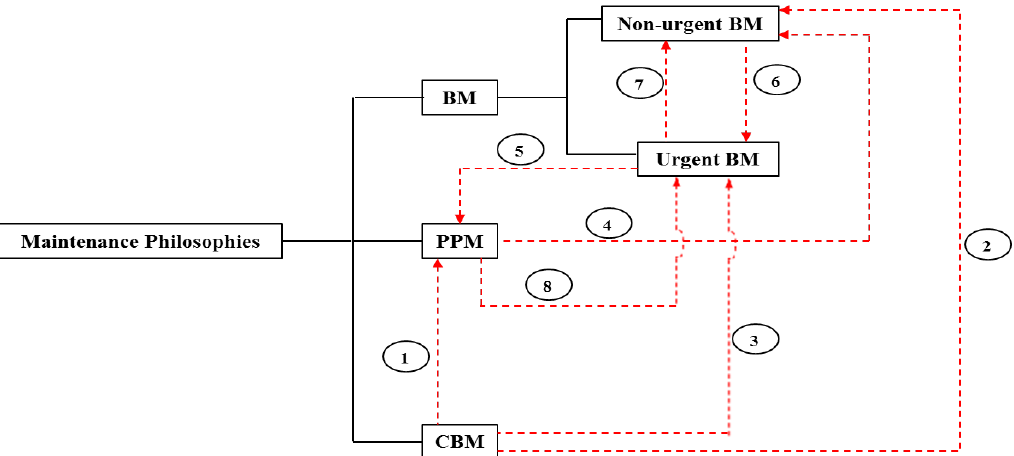
Figure 4. Maintenance philosophies and their interdependence.